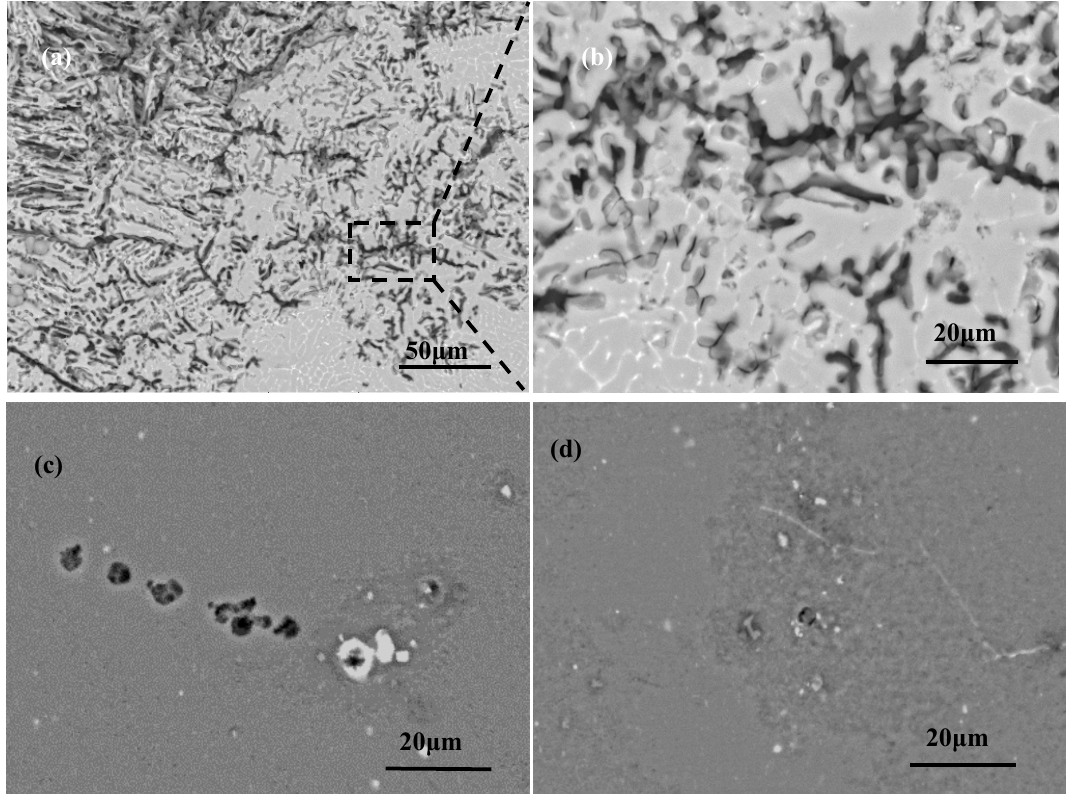
Figure 6. Surface morphologies of local areas of the 2060 Al–Li alloy laser welding joint after immersion corrosion in 3.5% NaCl solution for 72 h. ( a ) weld metal; ( b ) partially enlarged detail of the weld metal; ( c ) base metal; ( d ) heat-affected zone.